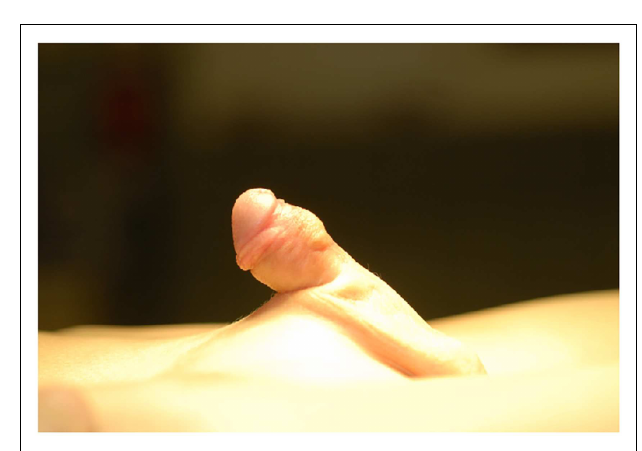
FIGURE 5 |Appearance of the penis 3months post